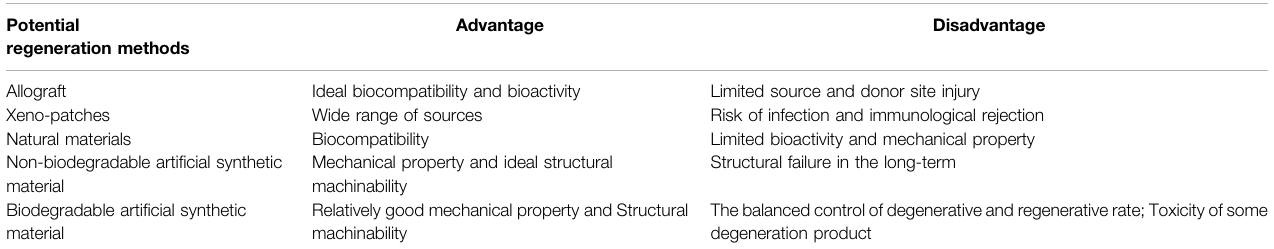
TABLE 2 | Promising treatments ’ advantage and